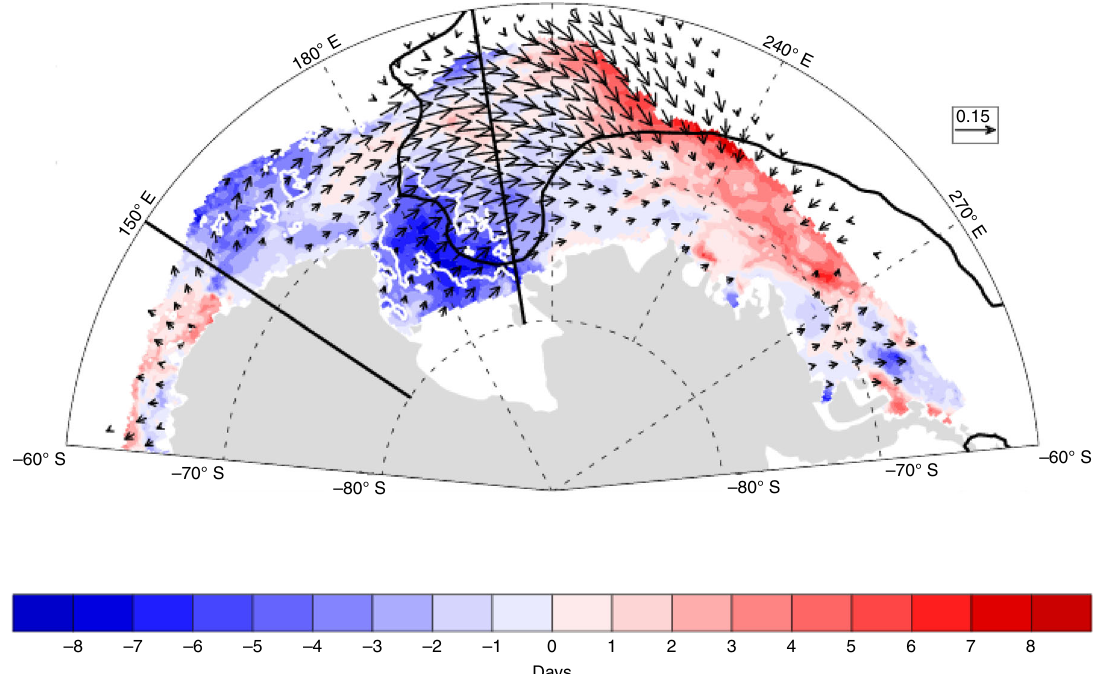
Fig. 3 Relationship of ice motion and ice retreat to the October zonal winds. Vectors indicate the regression of October ice motion on the October zonal wind anomaly index (from Fig. 1c). Colored shading indicates the timing of ice retreat regressed on the normalized October zonal wind anomaly index in units of days. The white contour indicates where negative regression values are signi fi cant at the 95% level. The black contour indicates the − 0.5 correlation of gridded October zonal winds and March Western Ross Sea ice area that is used to de fi ne the wind index (as shown on Fig. 1c). Vectors with a magnitude of < 0.02 are not